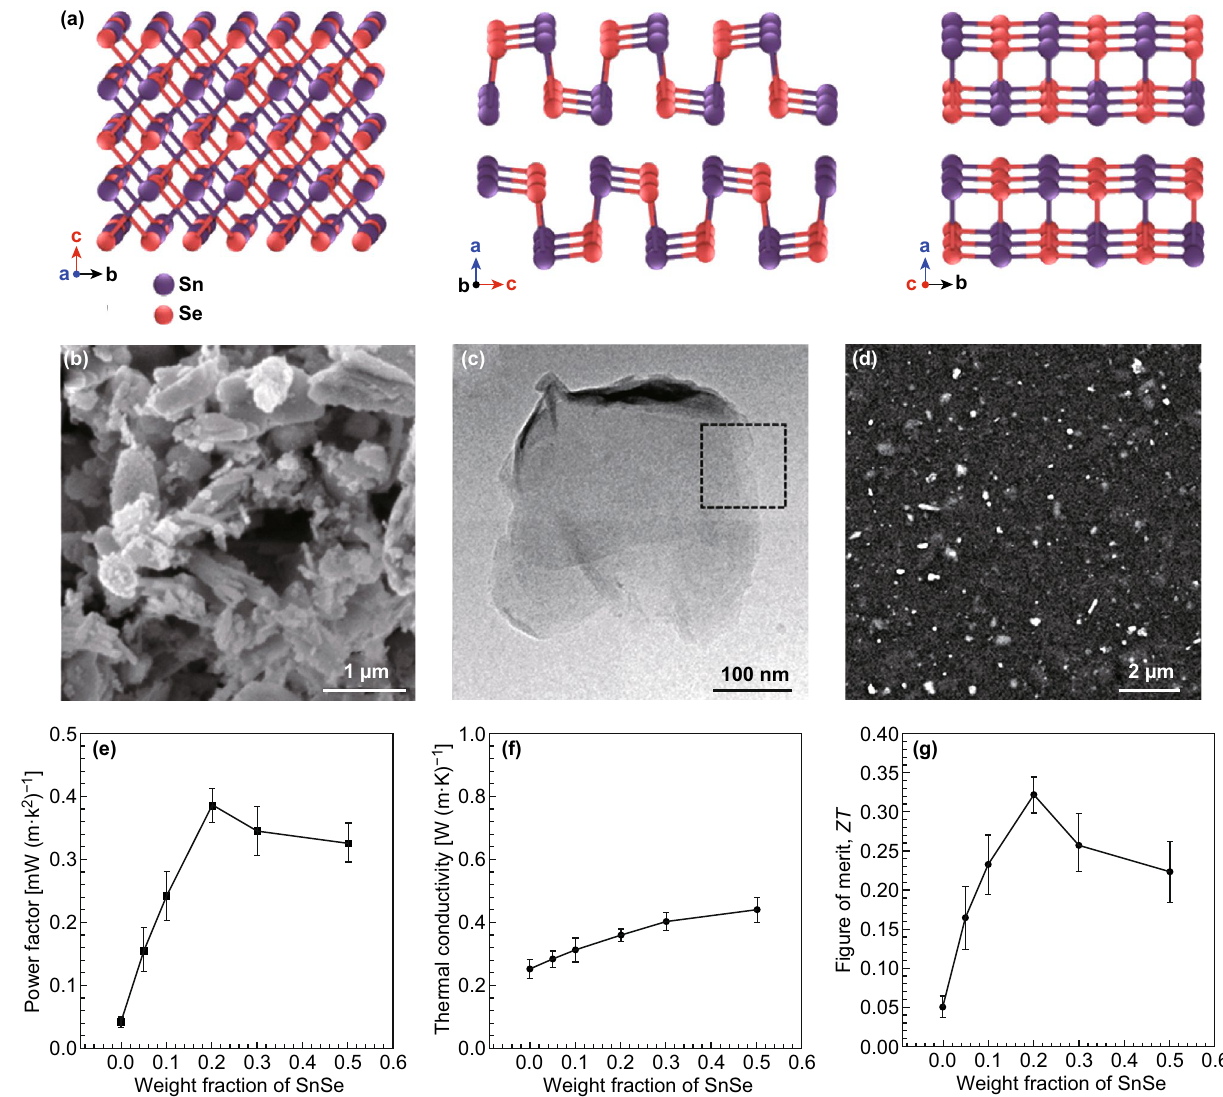
Fig. 11 a Crystal structures of SnSe along the a - , b -, and c - axial directions. b SEM morphology and c TEM image of SnSe nanosheets. d SEM of the SnSe/PEDOT:PSS composites with SnSe a content of 50%. e Power factor, f thermal conductivity, and g ZT value of the SnSe/ PEDOT:PSS composites. Reproduced with permission from Ref. [205]. Copyright 2016, American Chemical